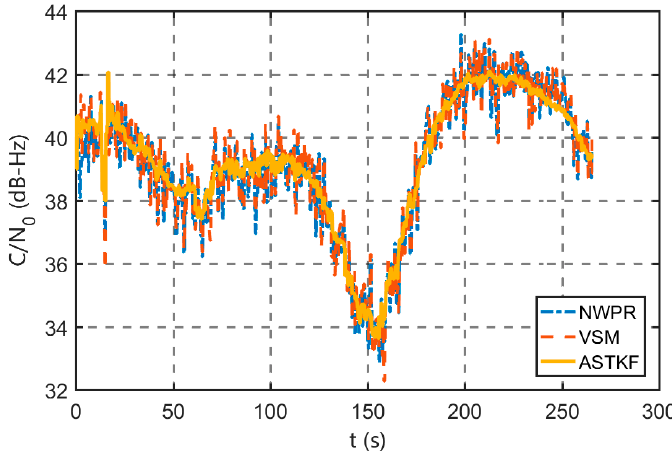
Figure 13. Satellite 24 C/N 0 (0.5 s averaging time).